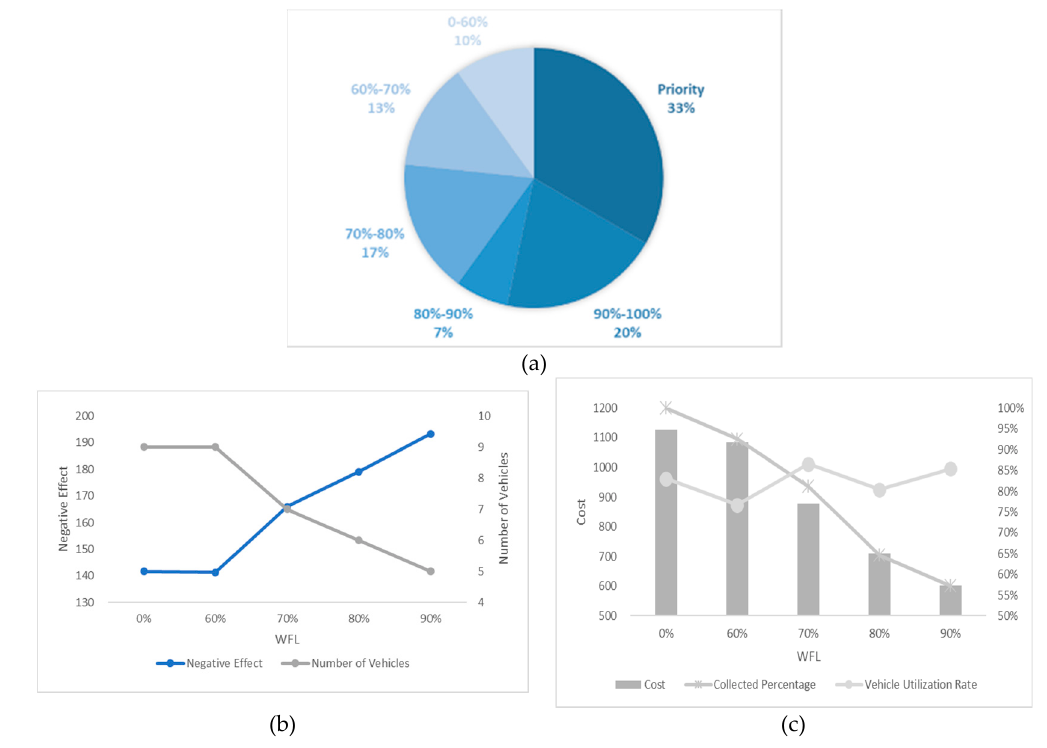
Figure 13. Results with 10 high-priority waste bins. ( a ) PCS-10 distribution of various waste bins, ( b ) PCS-10 negative effect and number of vehicles and ( c ) PCS-10 cost and vehicle utilization rate.